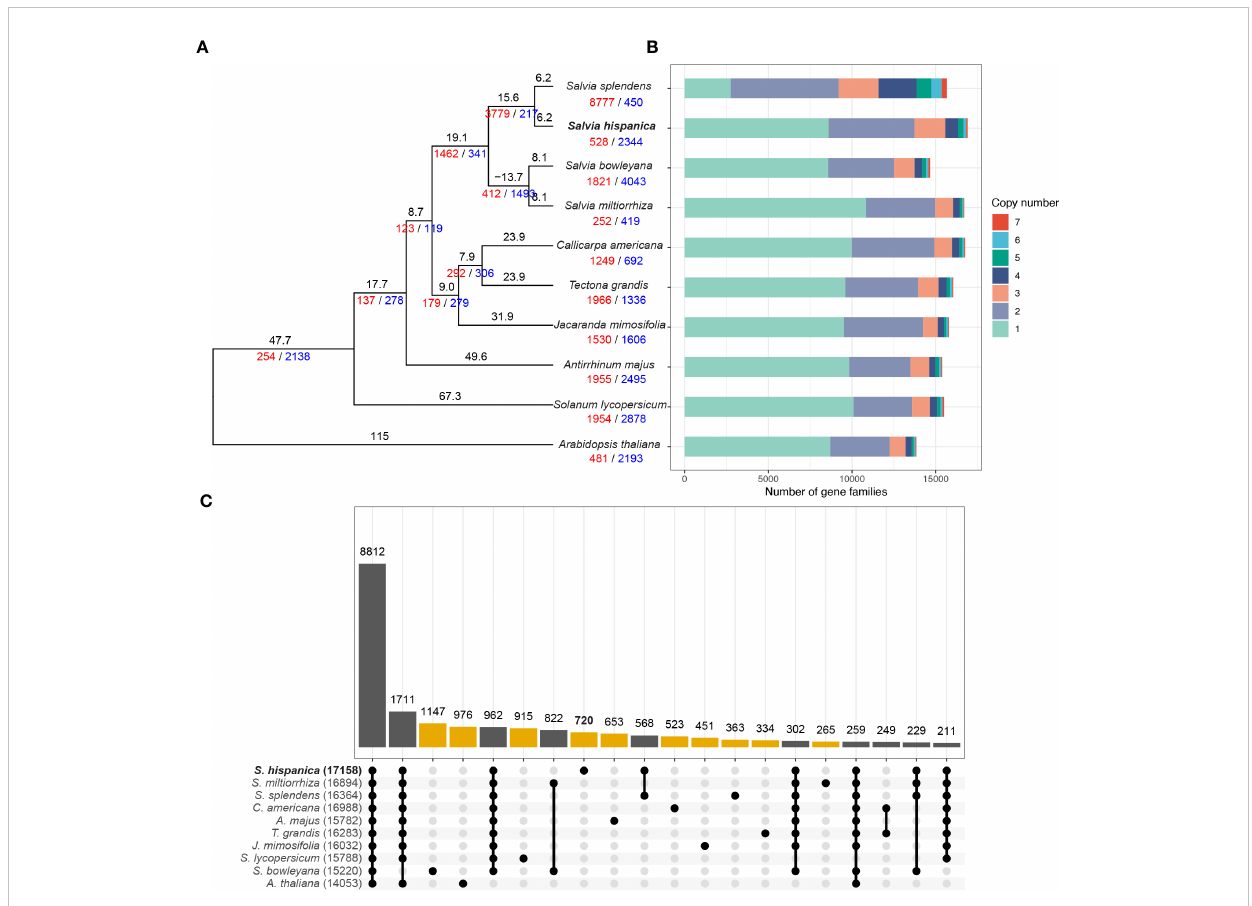
FIGURE 3 Evolution of the chia genome. (A) Phylogenetic tree for chia and 9 other plant species. Numbers of expanded and contracted gene families were indicated with red and blue numbers at each branch point. Branch length indicate the estimated divergence time in million years ago. (B) Numbers of gene families with different sizes (copy numbers) in each plant species. The X-axis indicate the number of gene families. (C) Upset plot indicating the number of gene families shared by different species. Yellow bars indicate numbers of species-speci fi c gene families, whereas gene families that are commonly identi fi ed in two or more species are indicated by dark gray bars. Filled circles with a connected line below the x-axis indicate the species that share a speci fi c number of gene